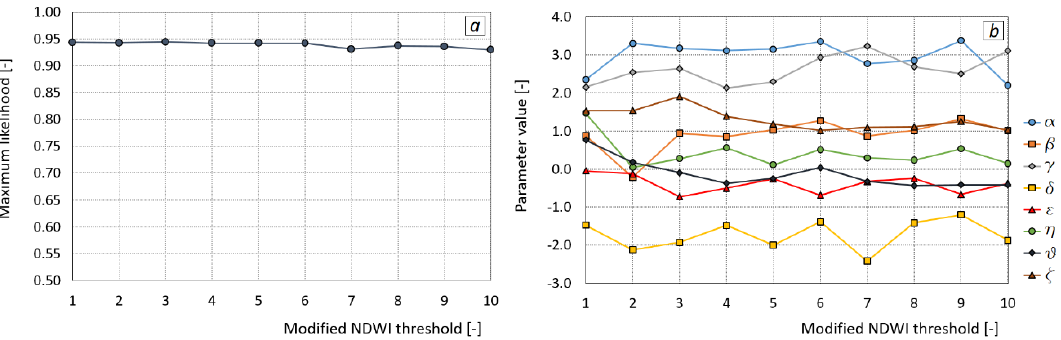
Figure 8. ( a ) Variation in maximum likelihood vs. NDWI m threshold and ( b ) variation in parameter values vs. NDWI m threshold.